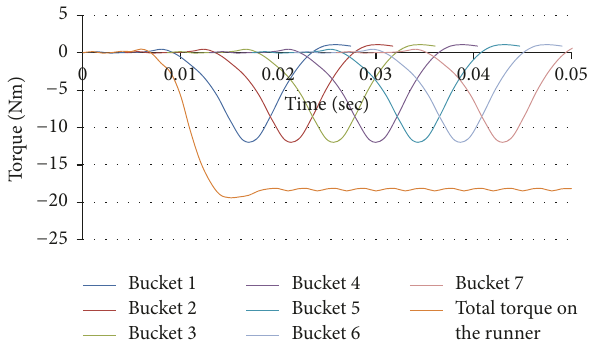
Figure 18: Dynamic runner and bucket torque over time for (PCD = 400